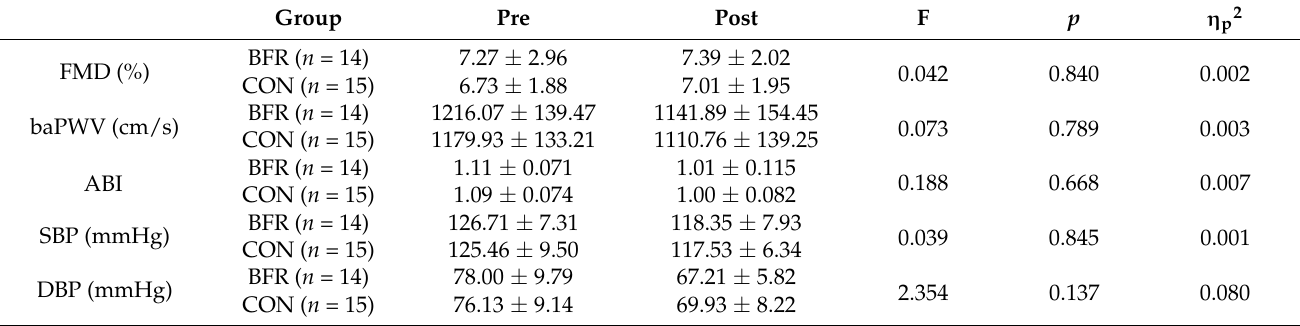
Table 4. Change in vascular responses after low-intensity aerobic training combined with BFR. Group